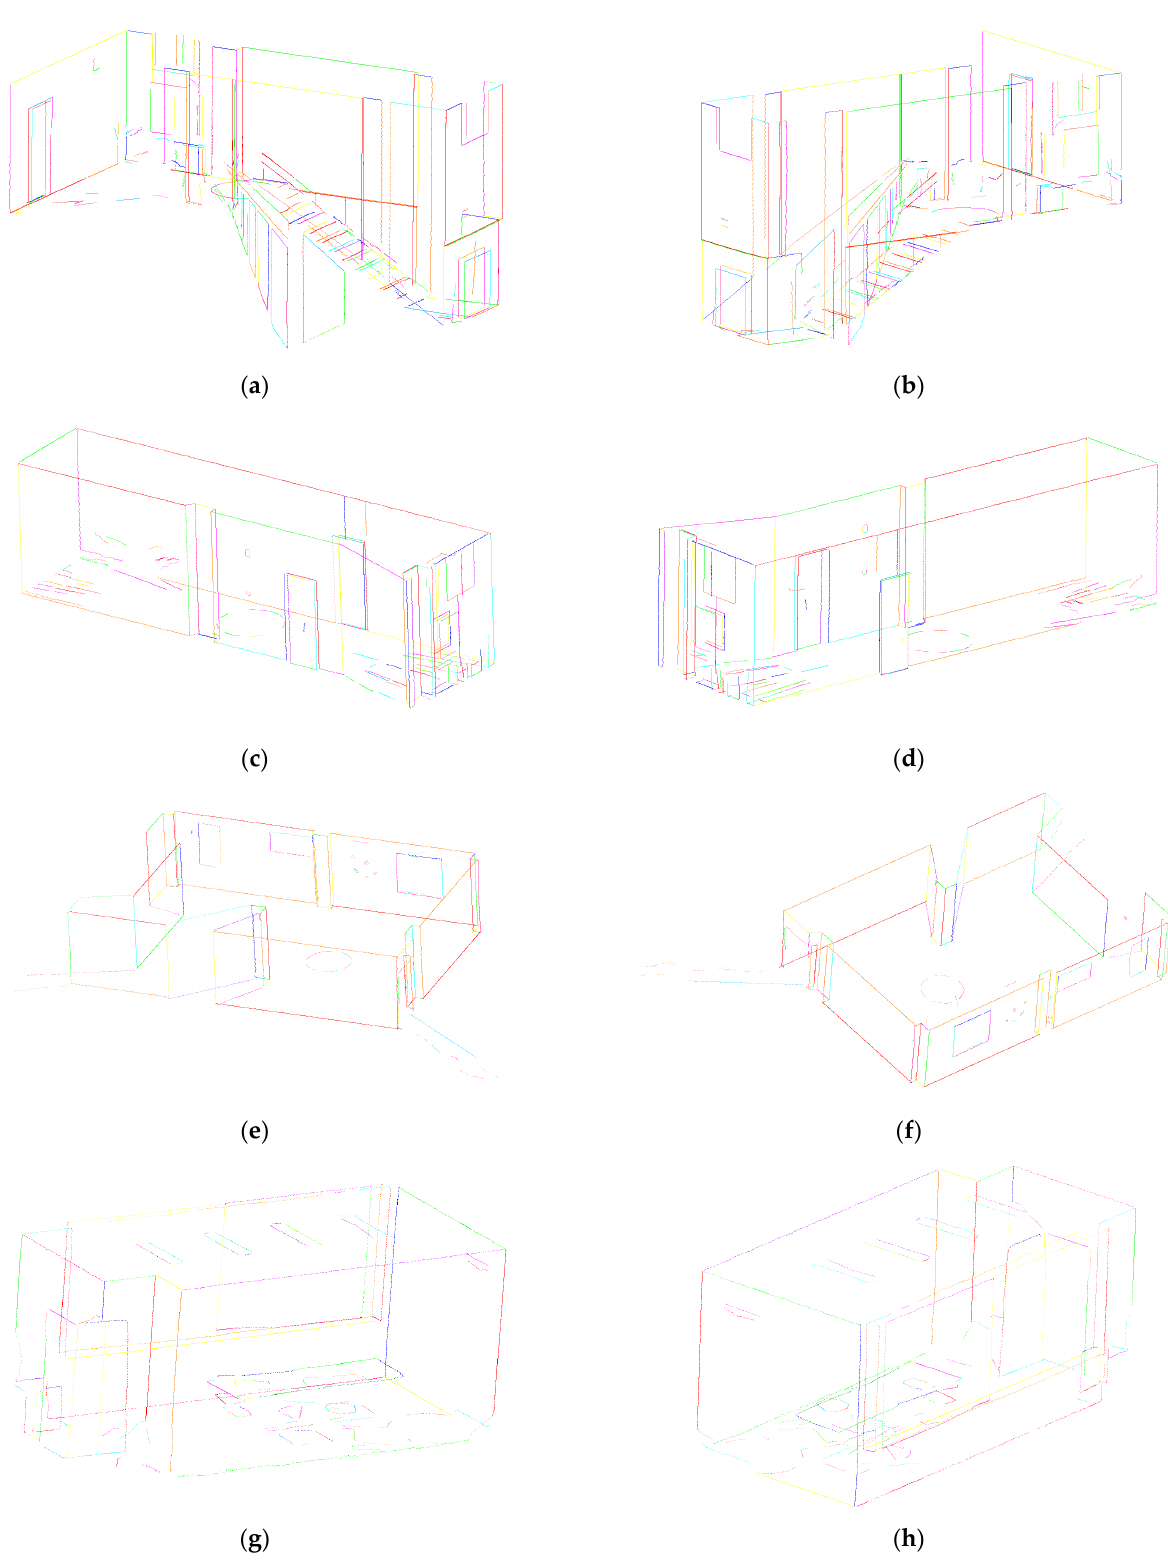
Figure 13. Three-dimensional line segments extracted by the proposed method. Each scene is shown from two angles. ( a , b ) Staircase. ( c , d ) Corridor. ( e , f ) Laboratory. ( g , h ) Lounge.